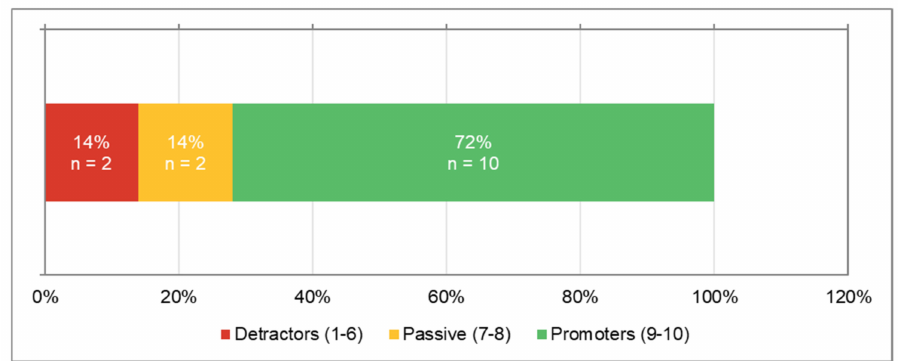
Figure 4. The importance of interoperability among different brands of chargers and EVs of same